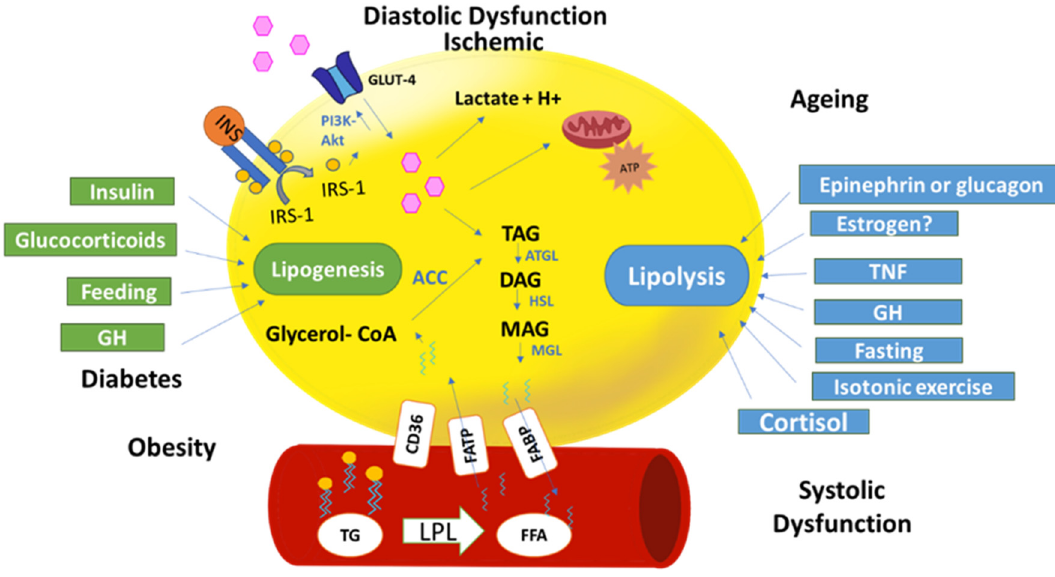
Figure 2. Epicardial fat metabolism in physiological and pathological situations: The figure represents an adipocyte (yellow) and a blood vessel. Glucose is the main fuel of energy in adipocytes to be used in adipocyte metabolism. Glucose or fatty acids can be stored in triacylglycerides (TAG) by a lipogenesis process. Insulin, glucocorticoids, and growth hormone (GH) promote lipogenesis. TAG through lipolysis produce free fatty acids (FFA). Several factors contribute to lipolysis (fasting, cortisol, etc.). Pathological conditions, diabetes, and obesity promote lipogenesis because of free fatty acid (FFA) uptake from the blood through fatty acids transporter protein (FATP). However, systolic dysfunction due, in part, by the epinephrine increment, promotes lipolysis. Diastolic and ischemic situation will increase glucose uptake for producing lactate and H + due to low oxygen